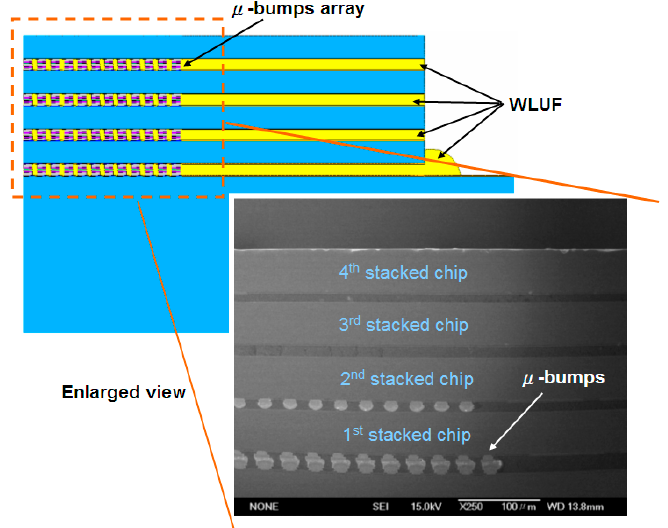
Figure 6. Enlarged cross-sectional views of specimens in the critical bump regions. The peripheral area is rich in WLUF.